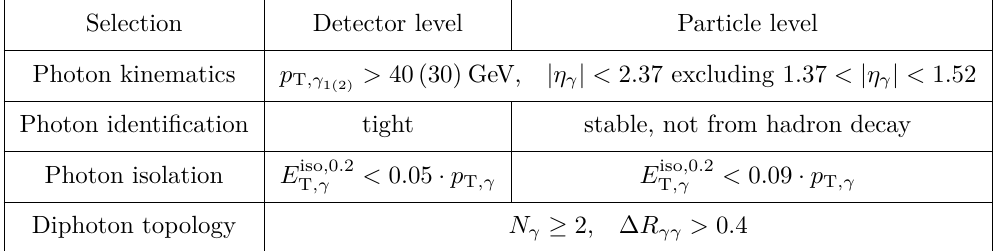
Table 1. Overview of the event selection at the detector level and at the particle level, i.e. definition of the fiducial phase